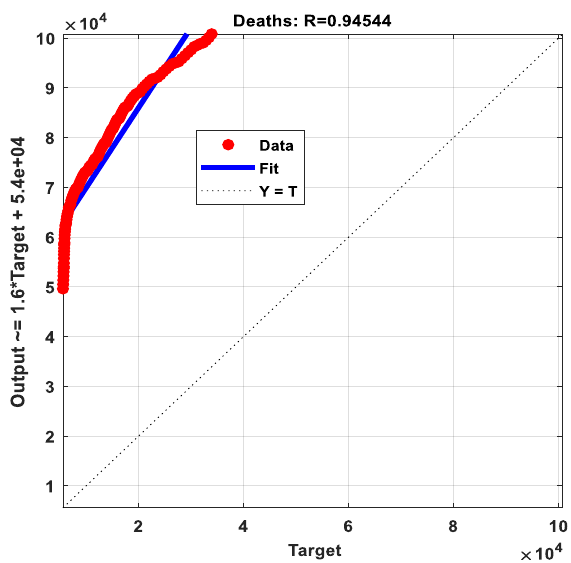
( c ) The correlations coefficients and the linear regression equations between the observed recovered values and the target values ( PPA-BMLPNN model values) for Brazil. Figure 6. The correlations coefficients and the linear regression equations between the testing data of (infected, recovered and deaths) and PPA-BMLPNN model values for Brazil. Figure 7 highlights the training data (in Red) and ANN-based predicted data (in Blue) for infected (active) cases of COVID-19 in Mexico, where the training data covers